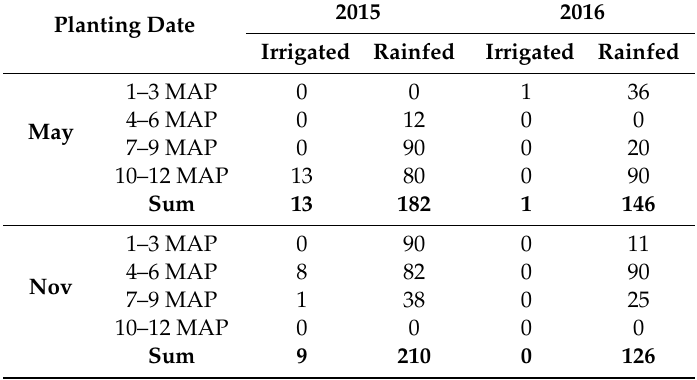
Table 4. The number of days on which the soil water potential fell below the critical threshold of Rayong 9 cassava under irrigated and rainfed conditions after planting in May and November 2015 and